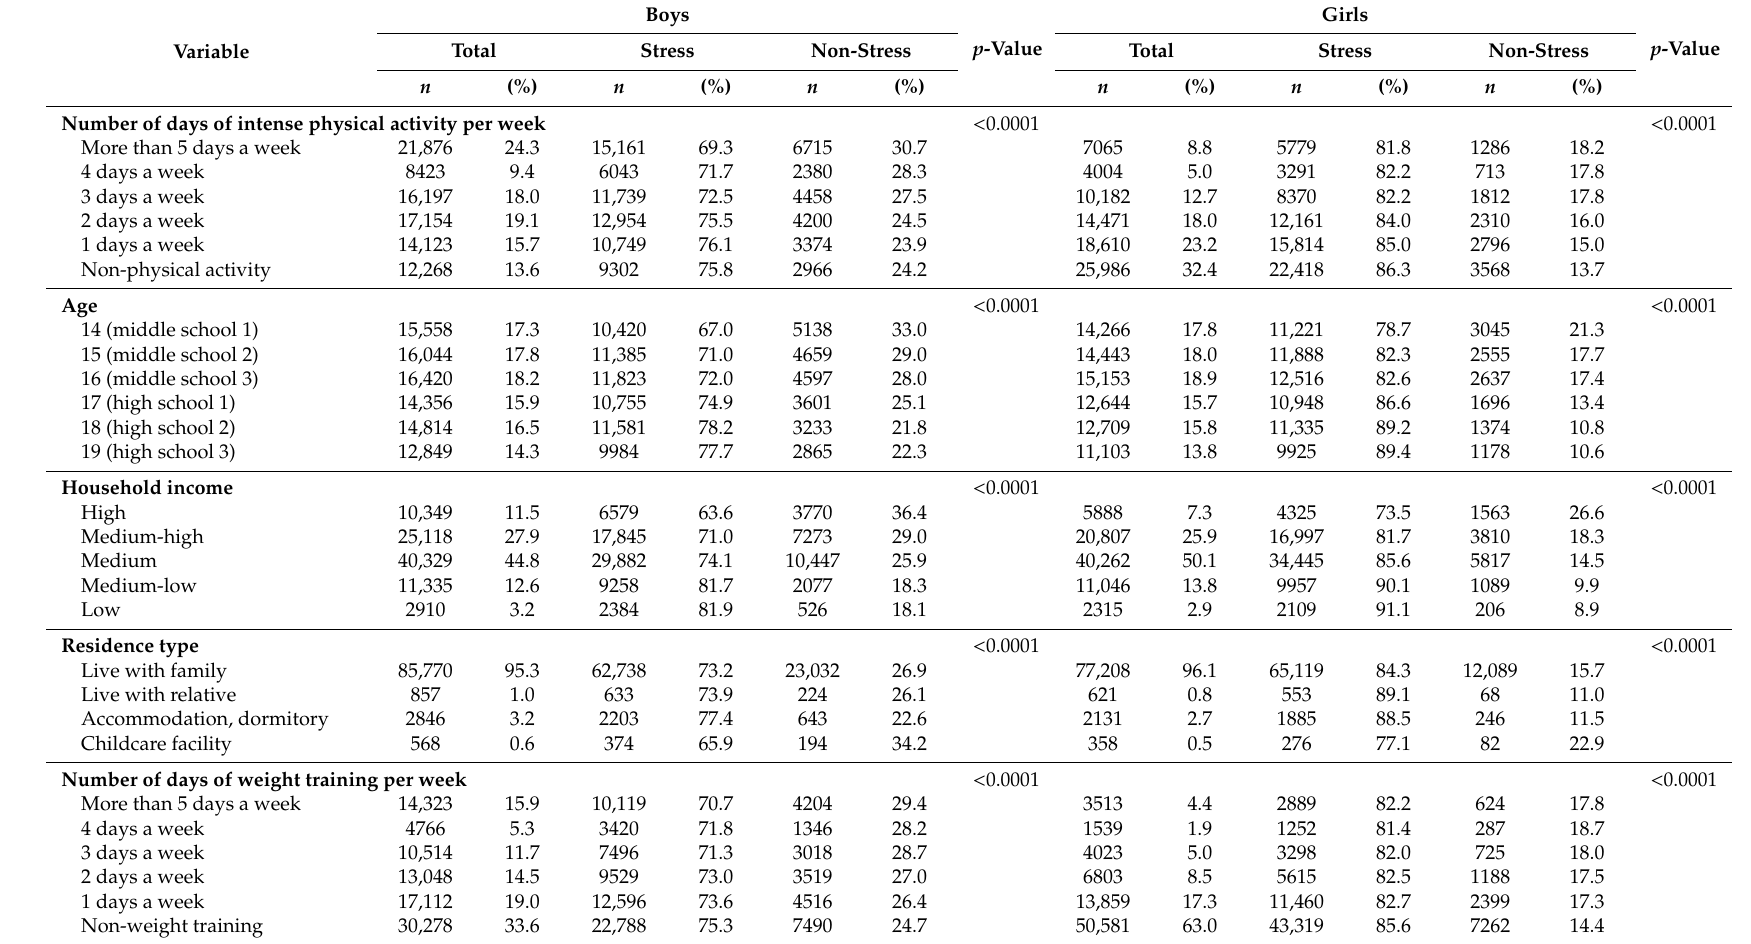
Table 1. General characteristics of study observations